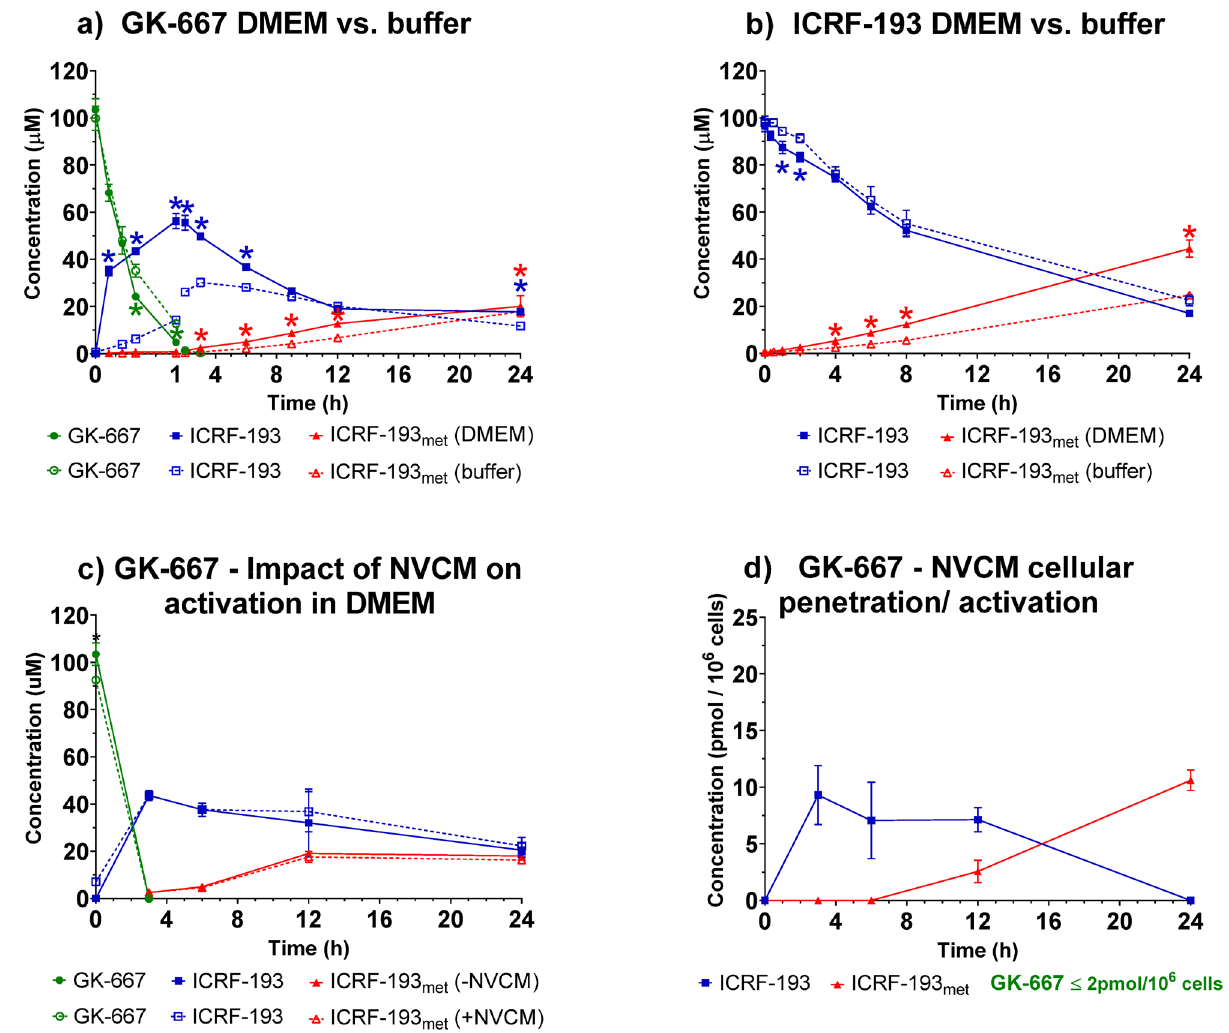
Figure 4. Activation of GK-667 and ICRF-193 in DMEM, the buffer and NVCMs. Concentration time profiles of the compounds after incubation of ( a ) GK-667 or ( b ) ICRF-193 (both 100 µM, 37 °C) in DMEM (solid symbols) and the buffer (open symbols). ( c ) Concentration time profile after incubation of GK-667 (100 µM, 37 °C) in DMEM with (open symbols) and without (solid symbols) neonatal ventricular cardiomyocytes (NVCMs). ( d ) Intracellular concentrations of the compounds after incubation of GK-667 (100 µM, 37 °C) with NVCMs. Data were collected from four independent experiments and are presented as the mean +/− SD. Statistical analysis was calculated in GraphPad Prism 8.4.3 using t -test correct for multiple comparisons using the Holm-Sidak method; P ≤ 0.005. *-compared to